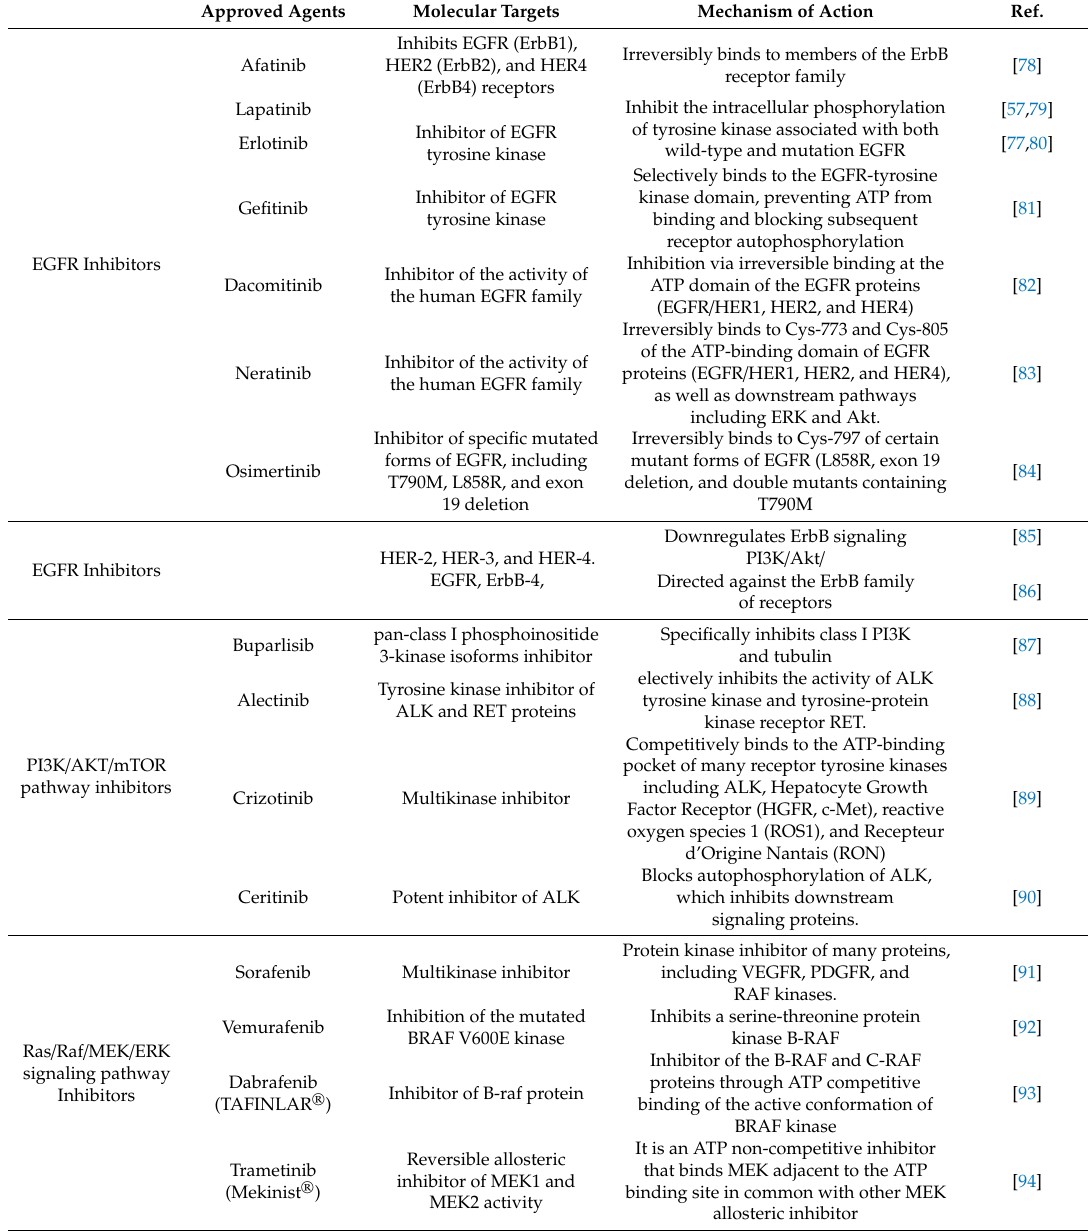
Table 2. Inhibitors and immunomodulators used in breast cancer